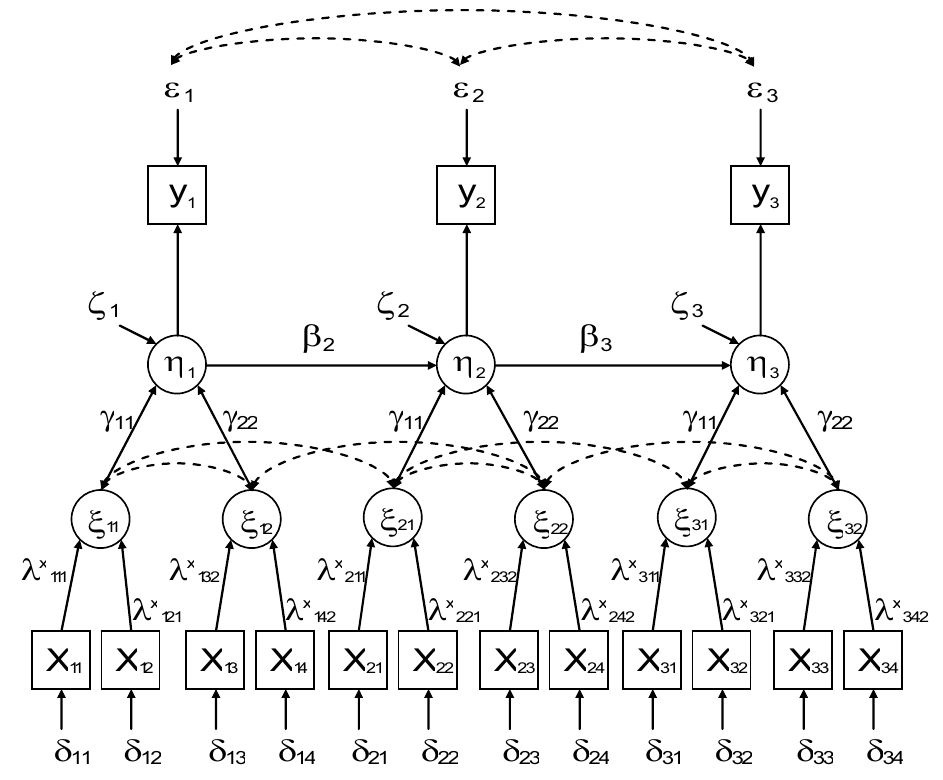
Figure 7 – The EXTENTED SIMPLEX model path